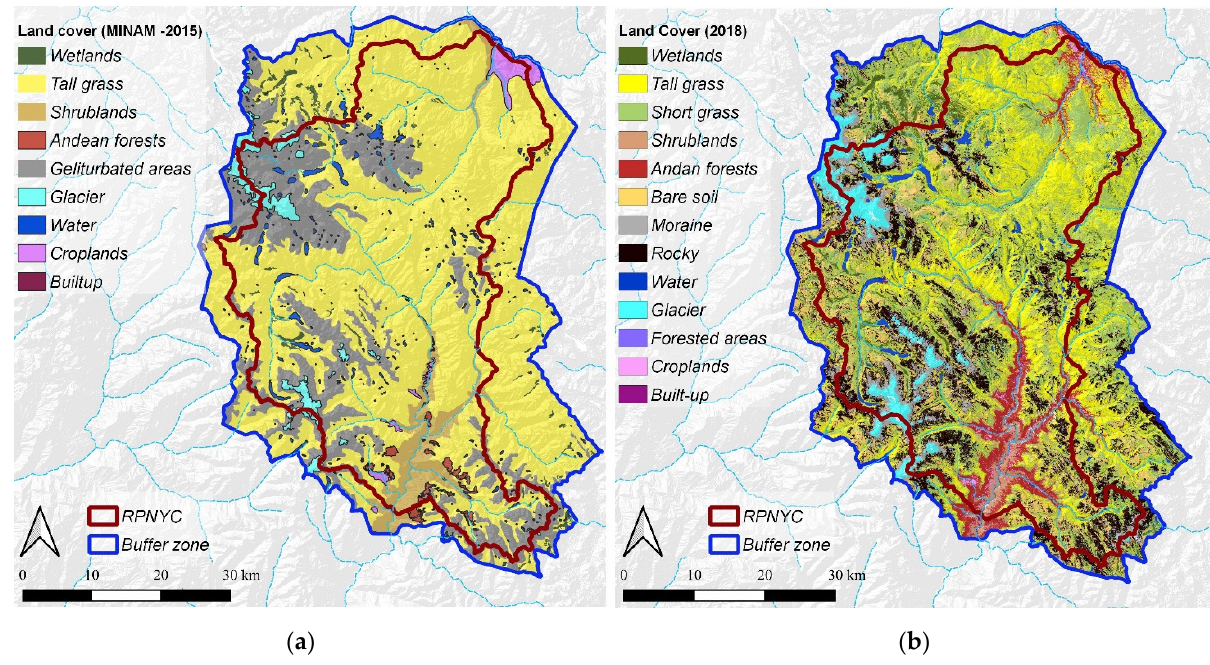
Figure 5. Spatial representation of the classification output with the highest overall classification accuracy: random forest + spectral bands + spectral indices + topographic layers ( a ) and the National Land cover map assessment 2015 ( b ).